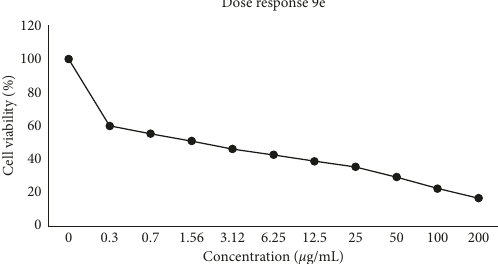
Figure 2: Effect of concentration of 9e on the cell viability